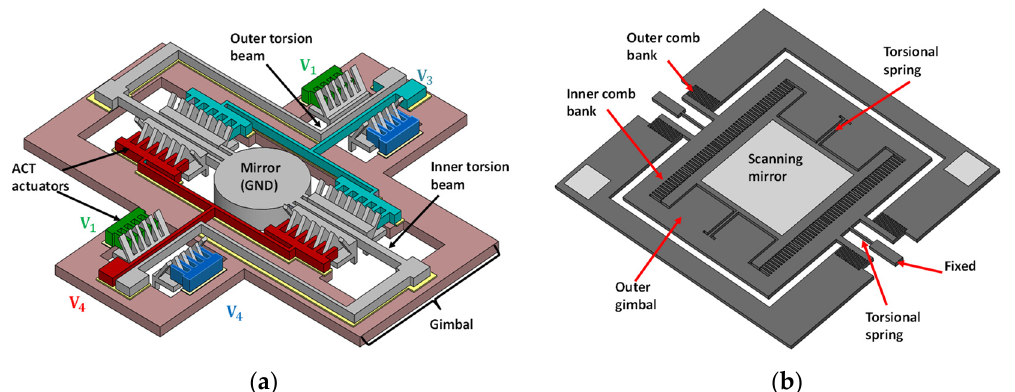
Figure 2. Schematic drawing of ( a ) the microelectromechanical systems (MEMS) scanner using an angular vertical-comb (AVC) actuator [15] and ( b ) the scanning mirror developed on single-crystal silicon and actuated with two vertical-comb structures [17].